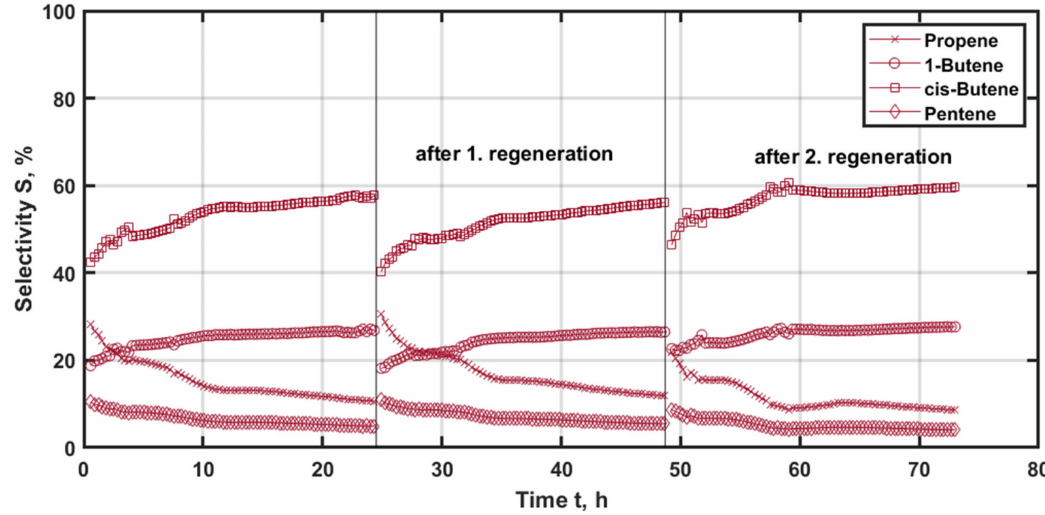
Figure 10. Selectivity of the main reaction products with time-on-stream (TOS) applying NiRe/mix (1:1) as the catalyst at 225 ◦ C and 500 kg cat · s · m − 3 , with regeneration at 500 ◦ C and 20% oxygen for 3